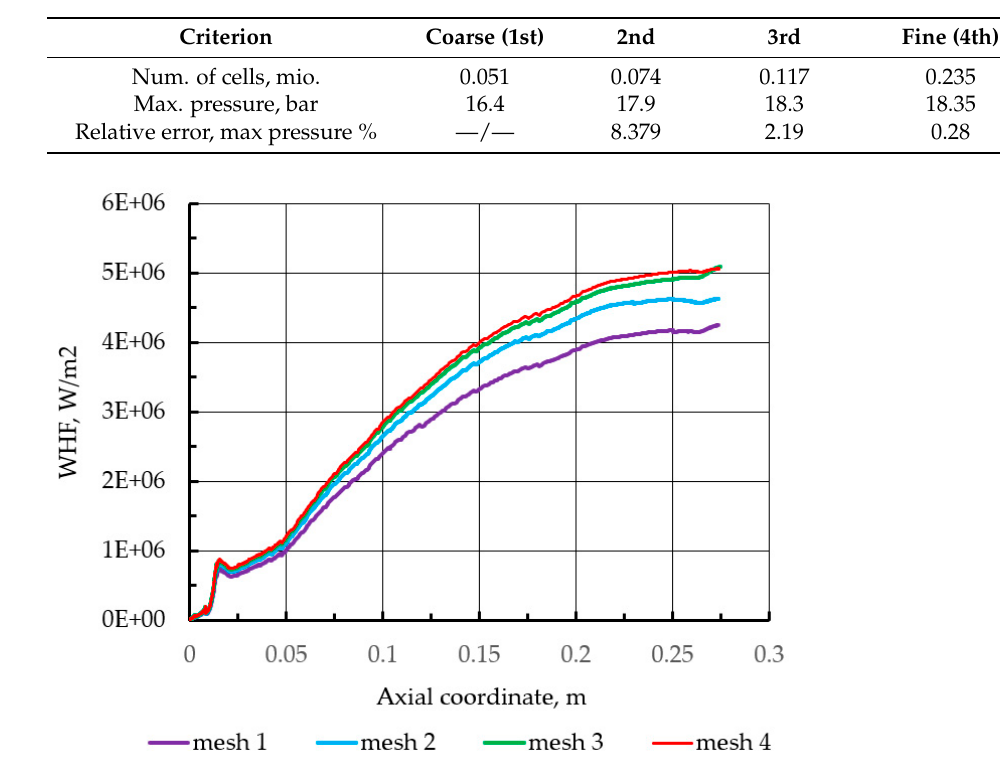
Table 1. Grid independence study.